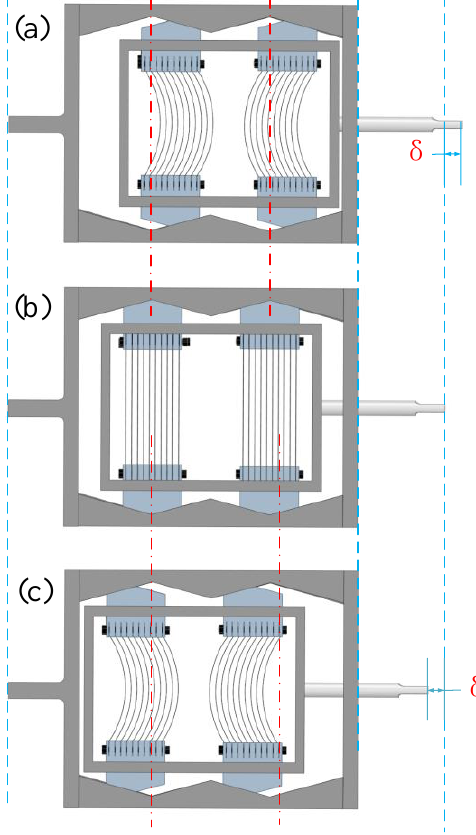
Figure 2. Working principle of BPSCFD: ( a ) Tension; ( b )Balance; ( c ) Compression.